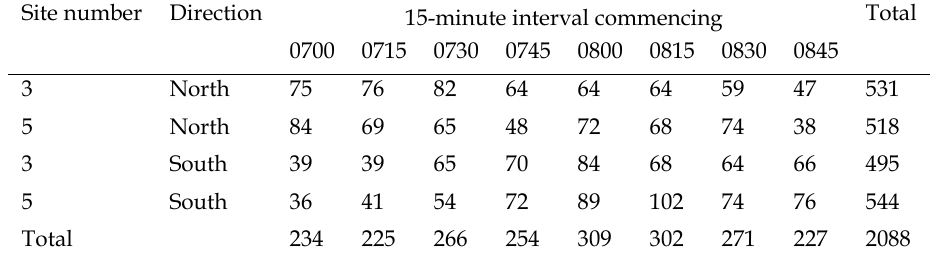
Table 4. Numbers of regular vehicles (N ≥ 30, σ≤ 10) by 15-minute time interval